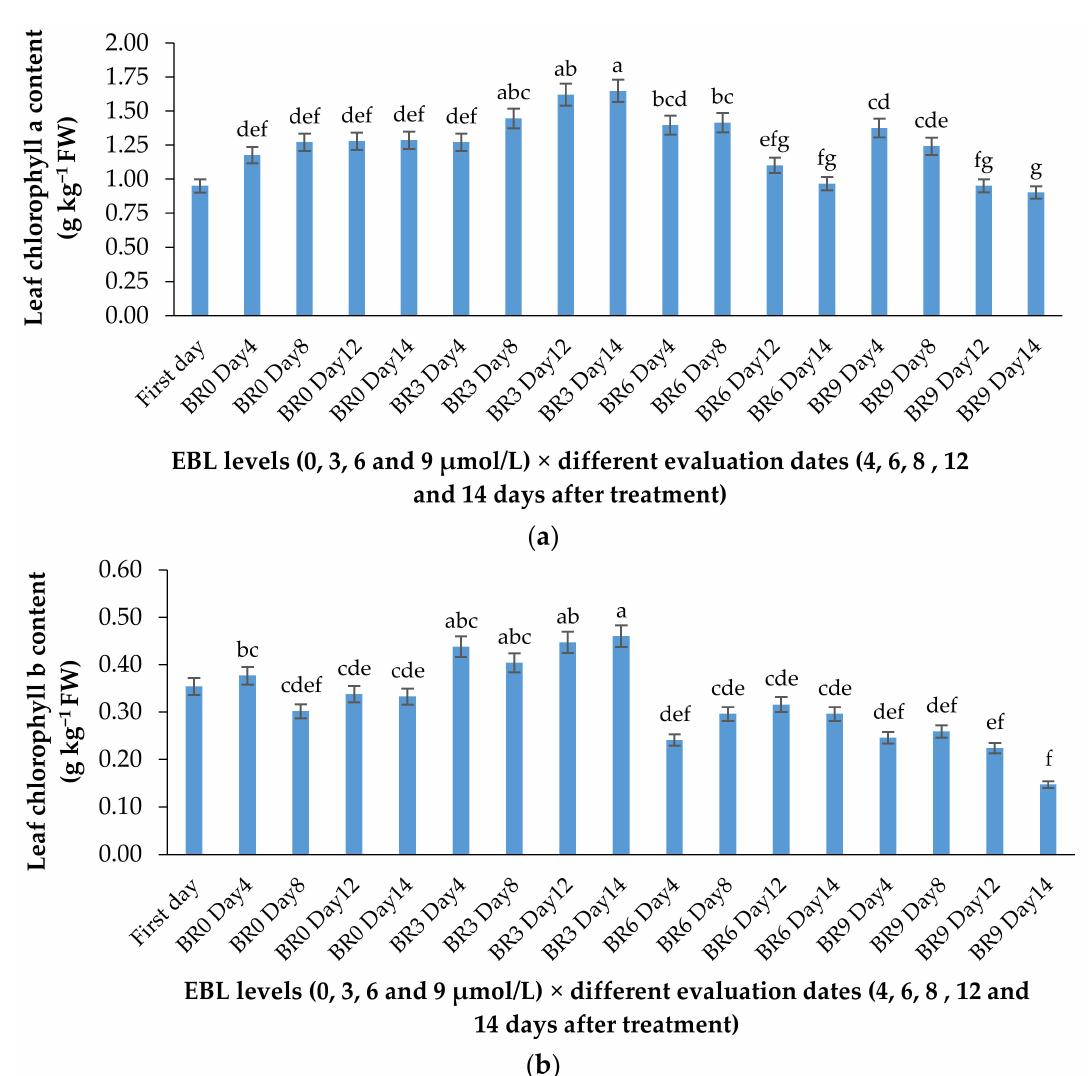
Figure 4. Effect of different concentrations of EBL on chlorophylls a ( a ) and b ( b ) content of lisianthus flower leaves at different evaluation dates. Error bars represent the standard error of means of four replicates. Columns indicated by different letters are significantly different according to Duncan’s multiple range test ( p ≤ 0.01). The first day is the harvest time of